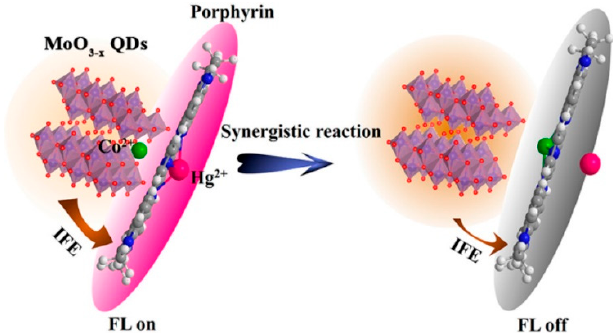
Figure 18. Strategy for Hg 2+ sensing on the basis of the synergistic effect of MoO 3 − x quantum dots (QDs) and Hg 2+ on the cobalt porphyrin formation. Reprinted with permission from ref [68]. Copyright 2018 American Chemical Society.